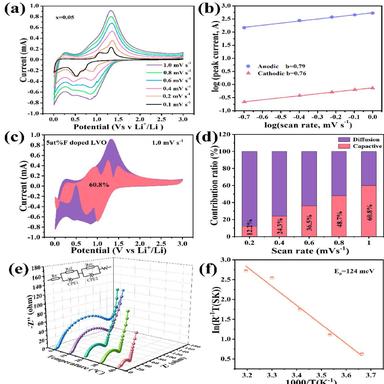
Electrochemical measurements for evaluating the kinetics of 5 at% F doping: (a) CV curves at various sweep rates from 0.1 mV s1 to 1.0 mV s1 ; (b) extracted log (i) vs log (v) plot; (c) capacitive contribution of the total capacity at a sweep rate of 1.0 mV s1 (Connecting specific voltage and k1v through a smooth curve and perform non-linear fitting to get figure c); (d) capacitive contribution proportion from 0.1 mV s1 to 1.0 mV s1 ; (e) temperature-dependent EIS spectra, and (f) the reciprocal of Rct is a